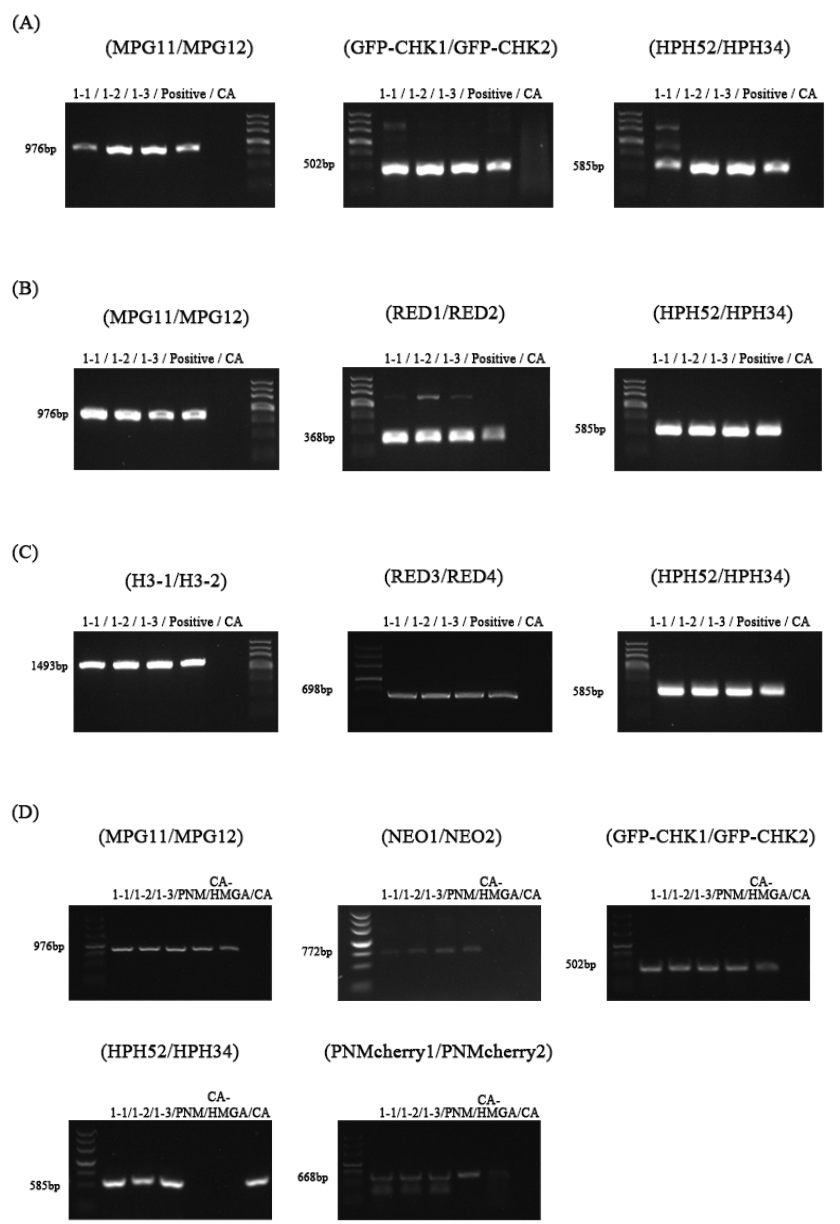
Figure 2. Confirmation of the fluorescent transformants using PCR amplification. The randomly selected CA-HMGA (( A ): 1-1–1-3), CA-HMR1 (( B ): 2-1–2-3), CA-mCherry-H2B (( C ): 3-1–3-3), and CA-HMGA-PNMcherryA (( D ): 2-1–2-3) transformants, three for each, were checked by PCR amplification with the primer pairs HPH52/HPH34, GFPCHK1/GFPCHK2, RED3/RED4, RED1/RED2, and PNMcherryA1/PNMcherryA2 to detect HPH, GFP, mCherry, RFP, and PNMcherryA fragments, respectively. CA: the wild-type strain; positive: the positive controls with the plasmids pHMGA, pHMR1, pKD9-mCherry-H2B, PNM, and CA-HMGA as templates; marker